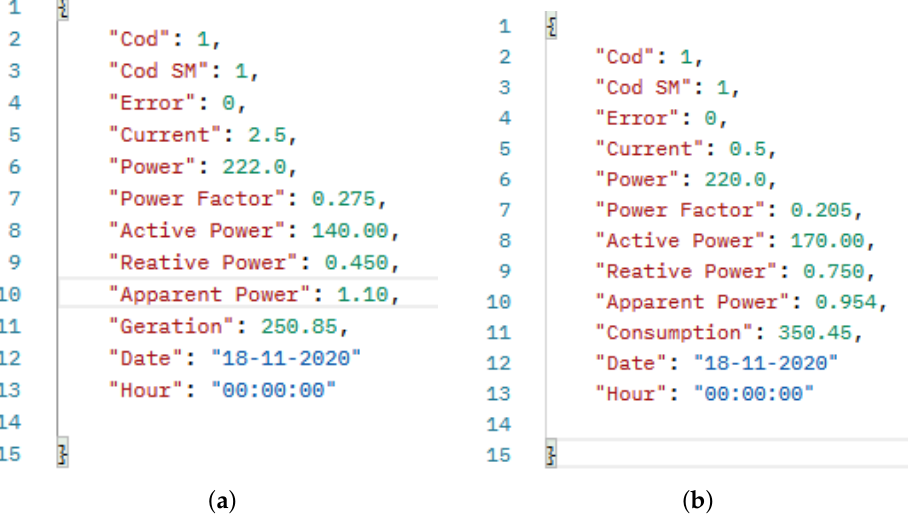
Figure 8. All JSON packages modeled to feed the application database. ( a ) JSON of the front generation record table. ( b ) JSON of the left consumption record table.